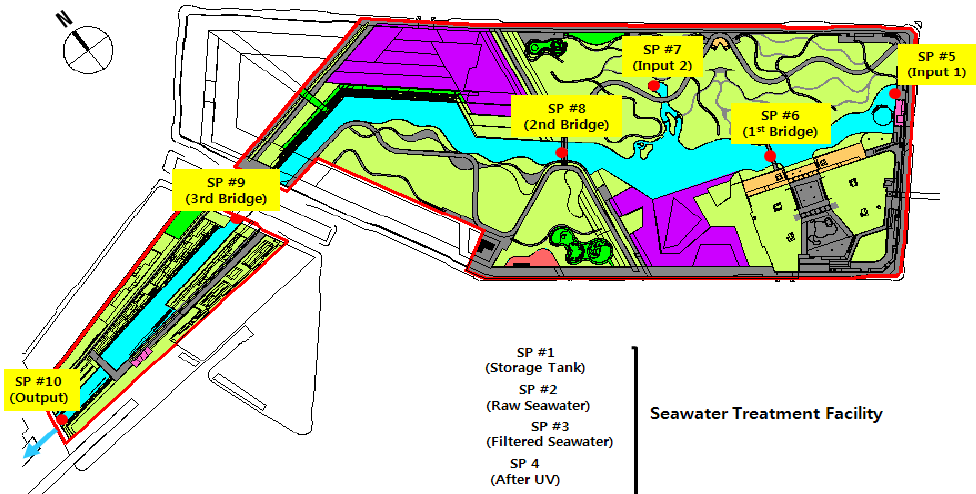
Figure 2. Sampling points (SP) for nutrients monitoring (T-N and T-P).